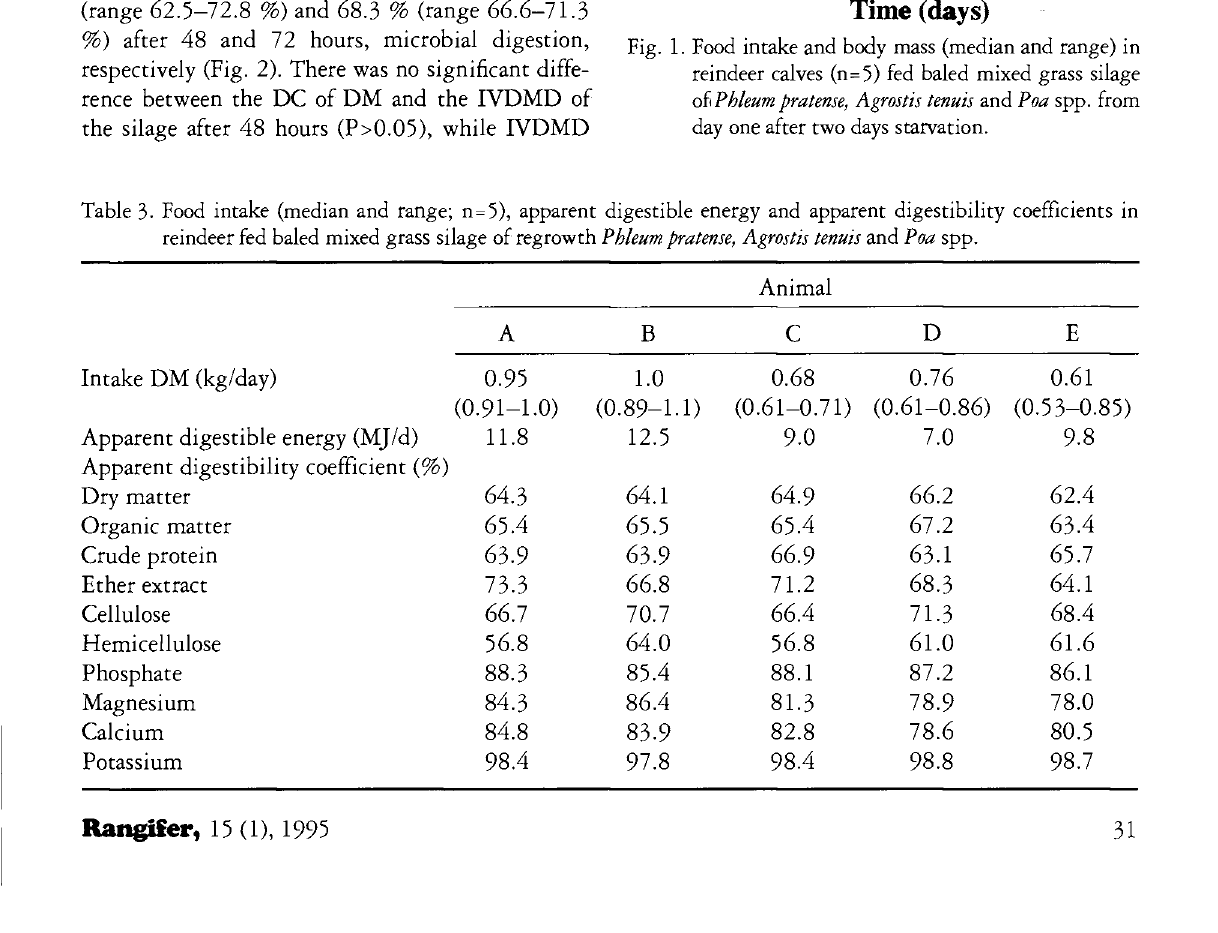
Fig. 1. Food intake and body mass (median and range) in reindeer calves (n=5) fed baled mixed grass silage of Phleum pratense, Agrostis tenuis and Poa spp. from day one after two days starvation.